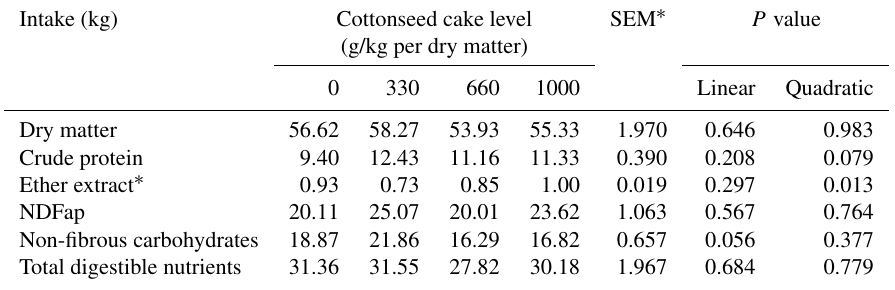
Table 2. Intake of nutritional components (kg in the entire experimental period) of feedlot goats fed diets containing cottonseed cake replacing soybean meal.